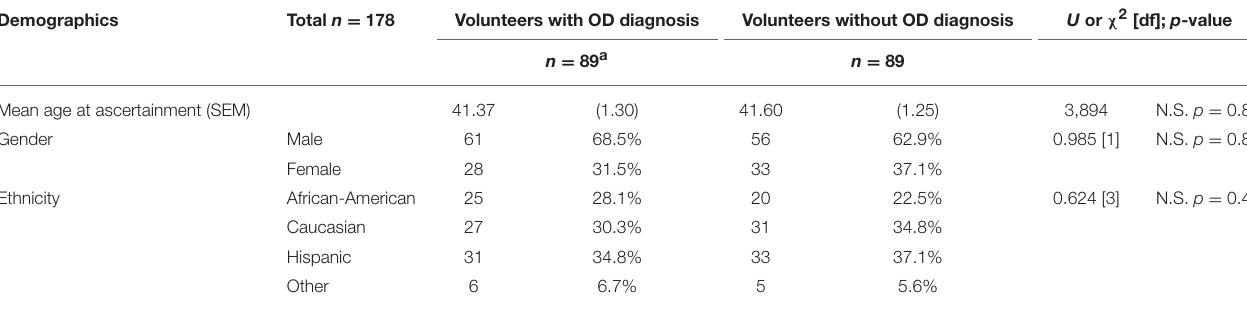
TABLE 5 | Demographics after the propensity score matching procedure (see Table 3B for data prior to the matching procedure).